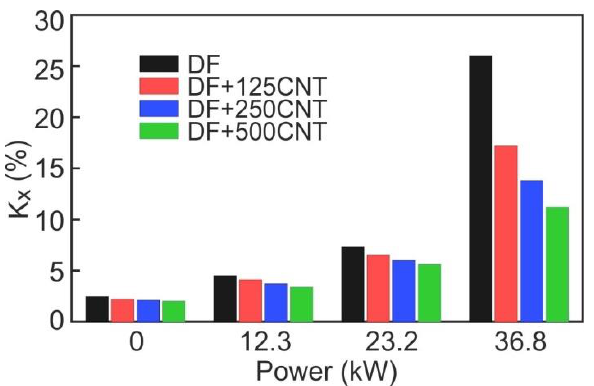
Figure 10. Change in exhaust smoke depending on the amount of CNT addition at different diesel engine loads.